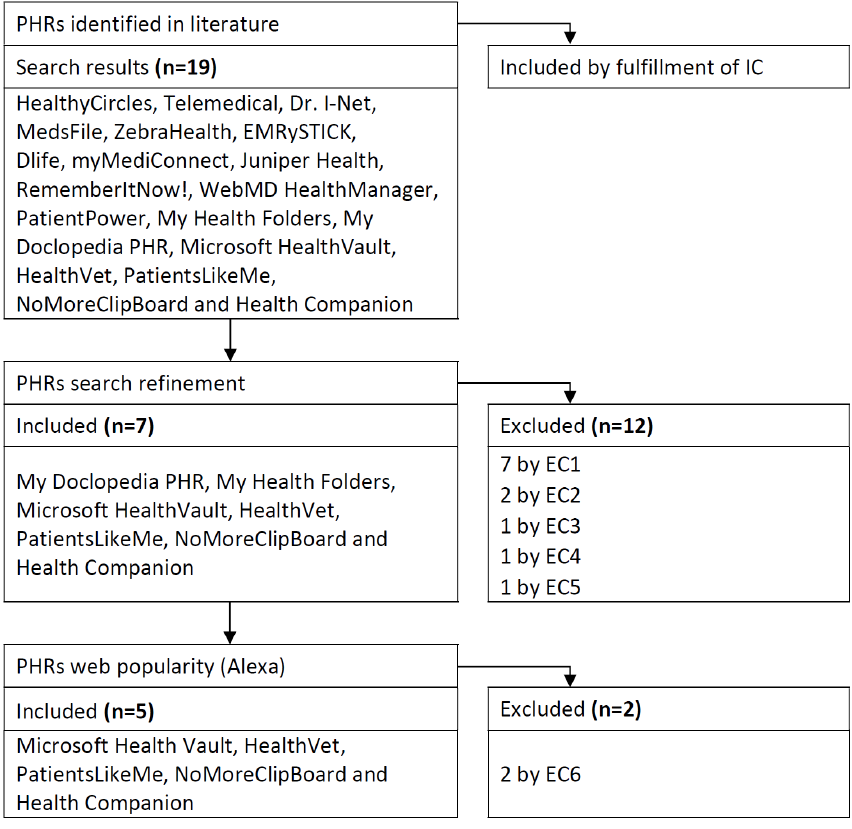
Figure 2. Prisma flow